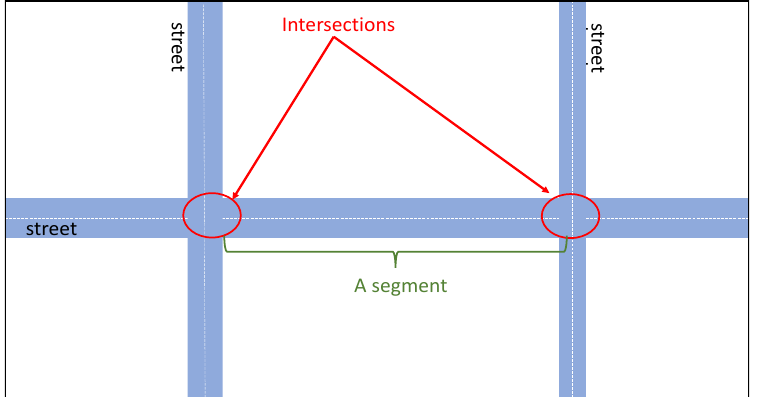
Figure 1. Intersection and segment